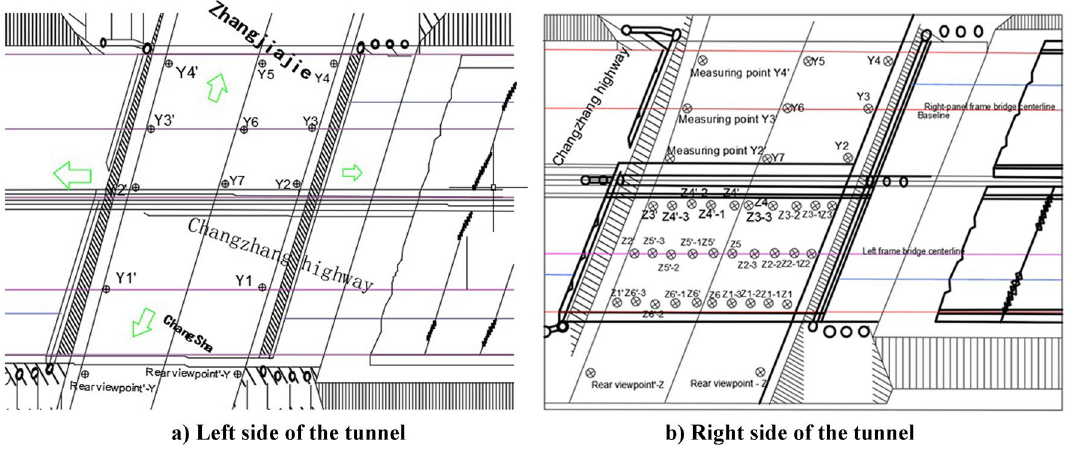
Figure 4. Layout of pavement deformation observation